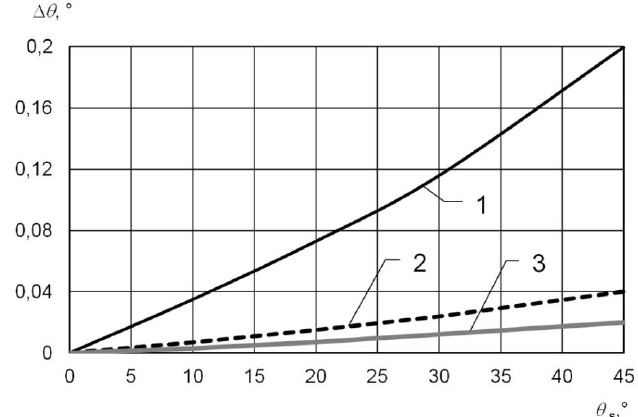
Fig. 7. Angular displacement of PAA difference radiation pattern minimum from a given direction depending on the angle of deflection of the beam for PAA with different